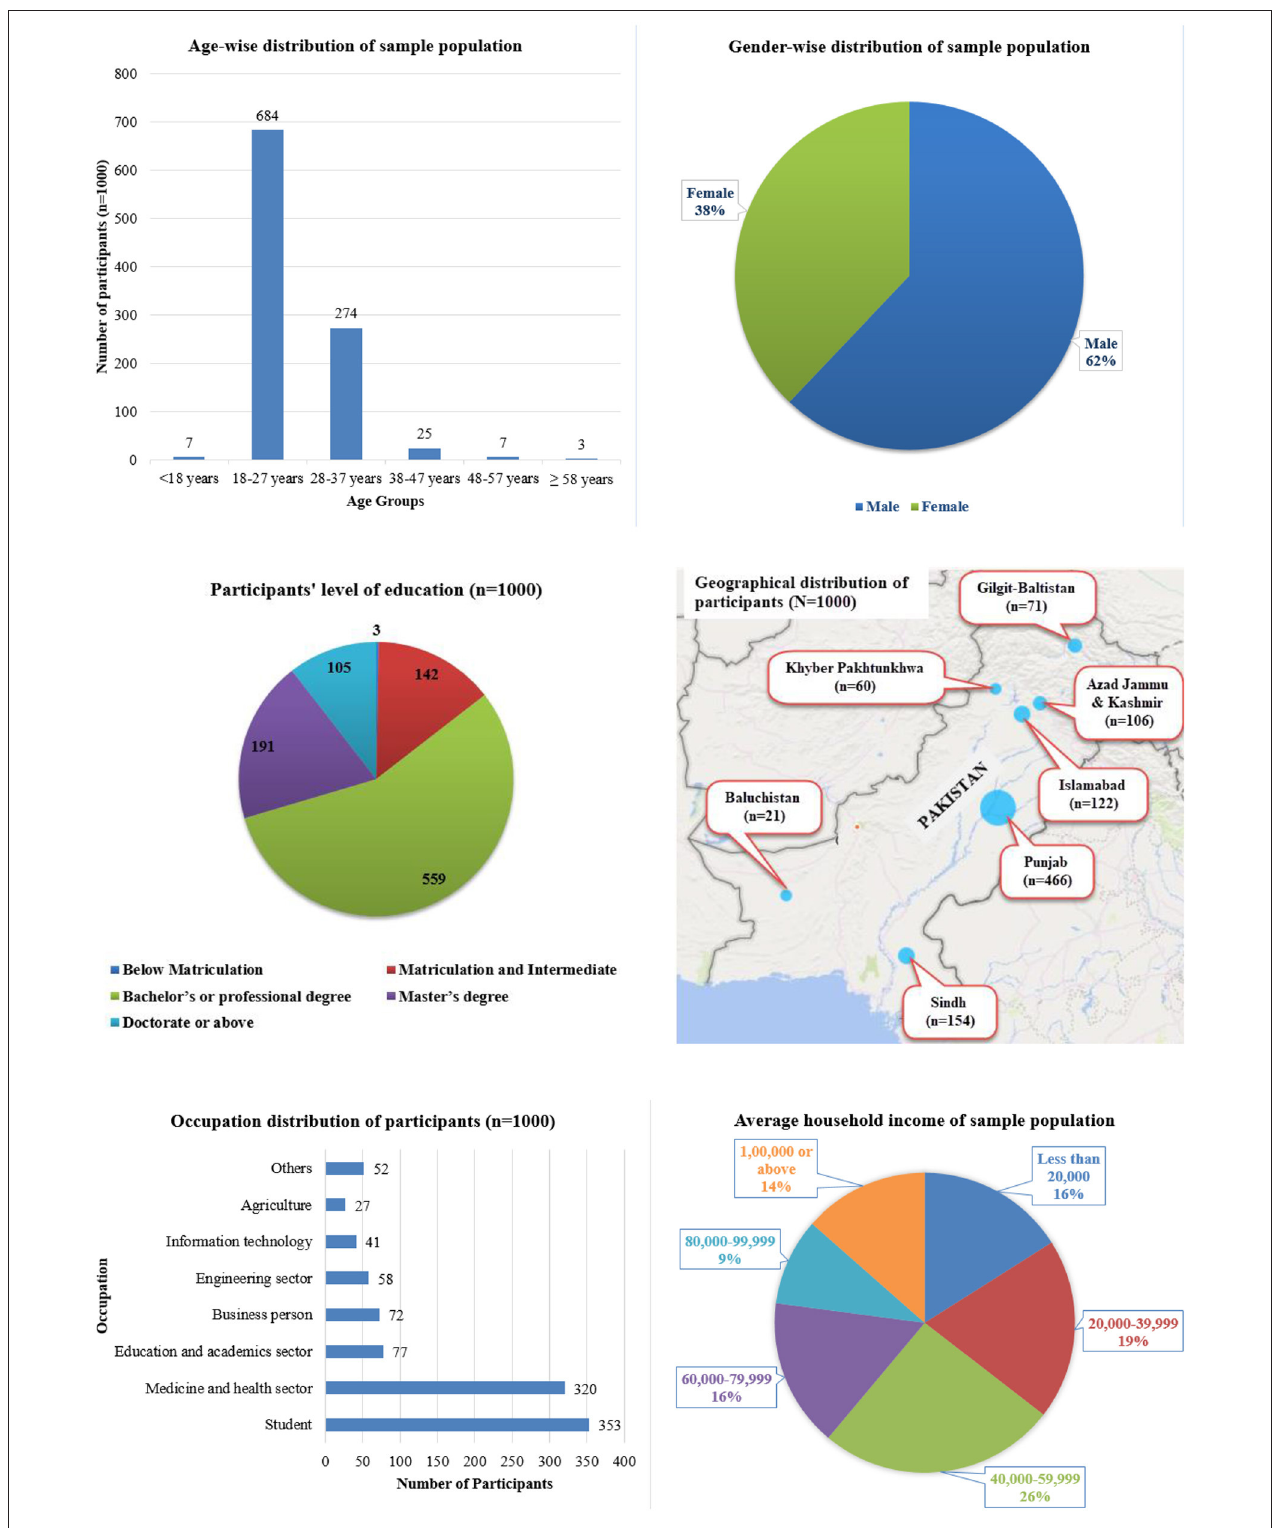
FIGURE 1 | Demographical features of the participants.